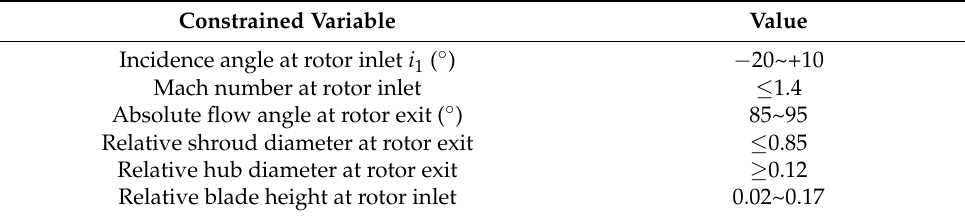
Table 2. Constraint